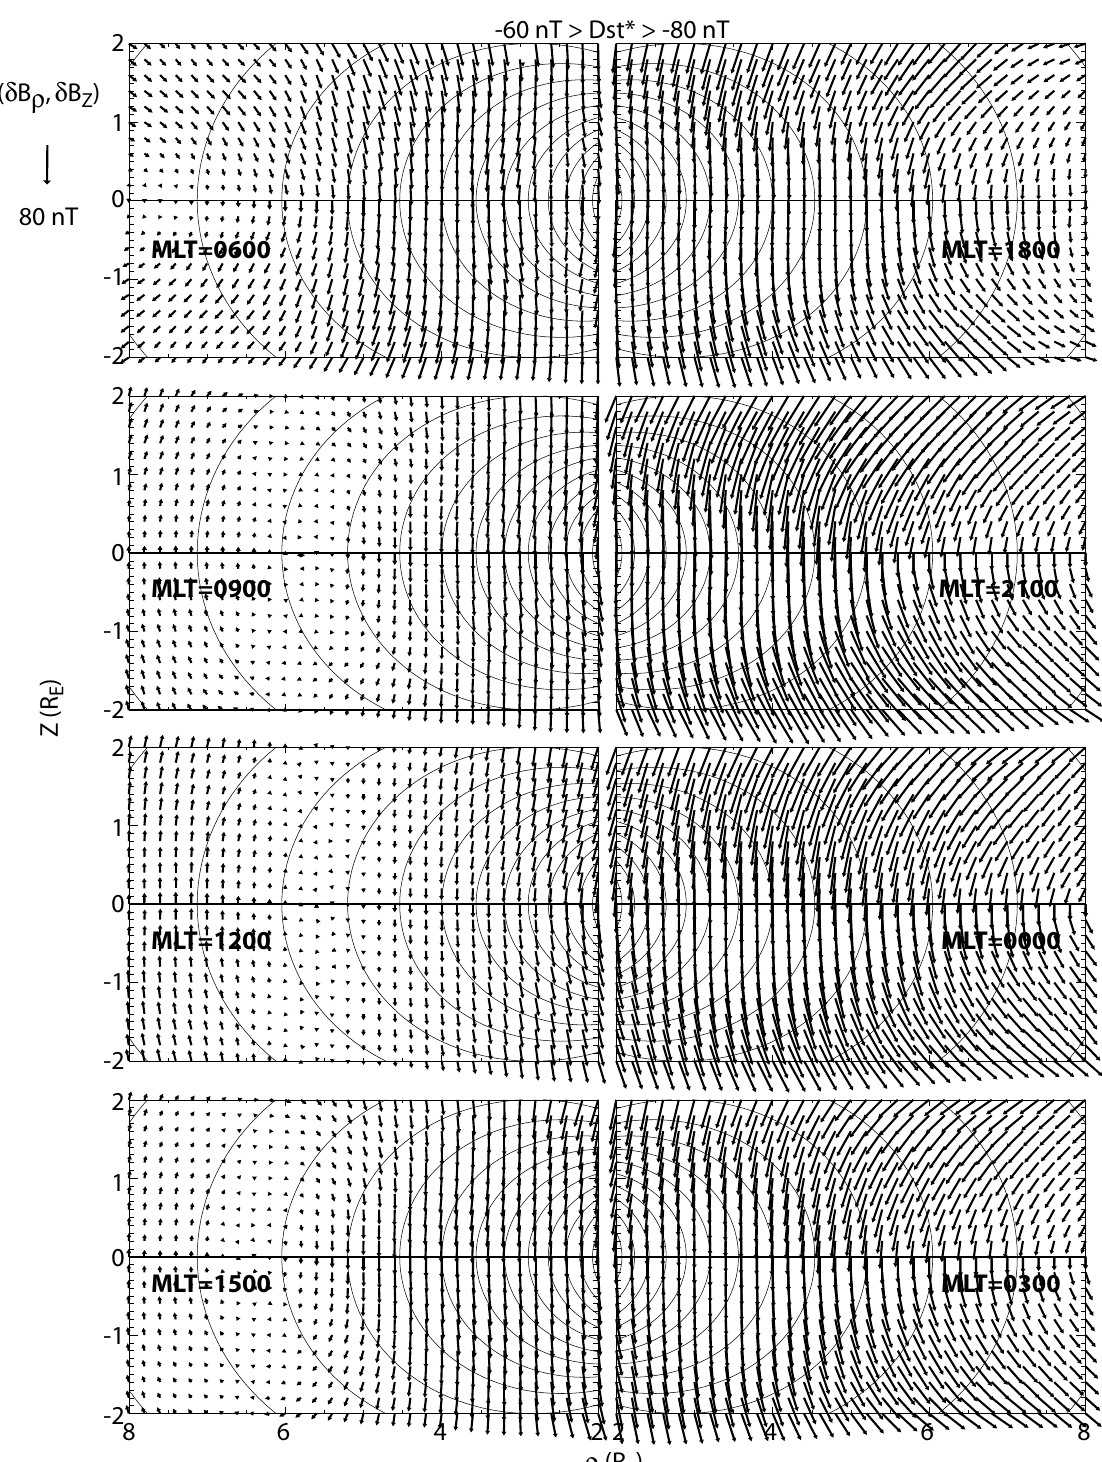
Fig. 4c. Meridional projection of the perturbation magnetic field arrows at equally spaced grids with superimposed dipole field lines in the meridian plane in each of the 8 magnetic local time bins and for each of the four D st * range: (c) − 60 nT >D st * > −